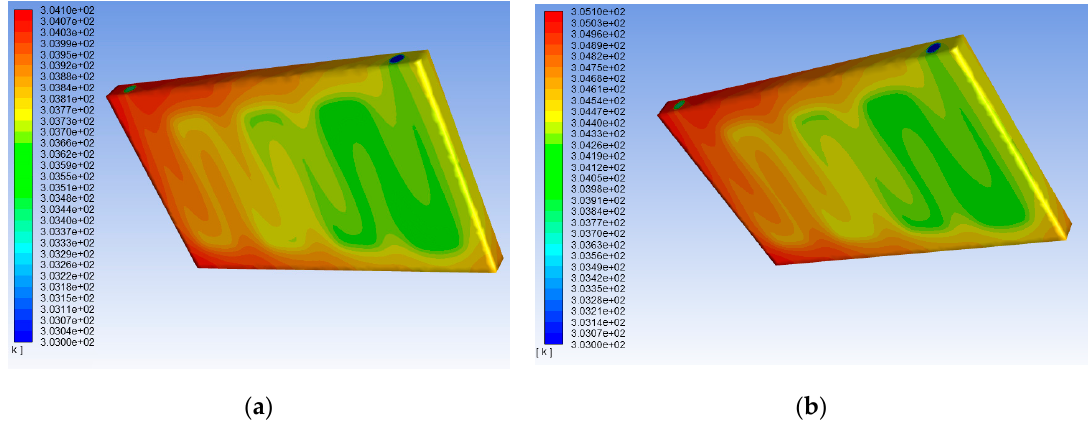
Figure 11. The temperature profile for different current rate: ( a ) 4C and ( b ) 8C.